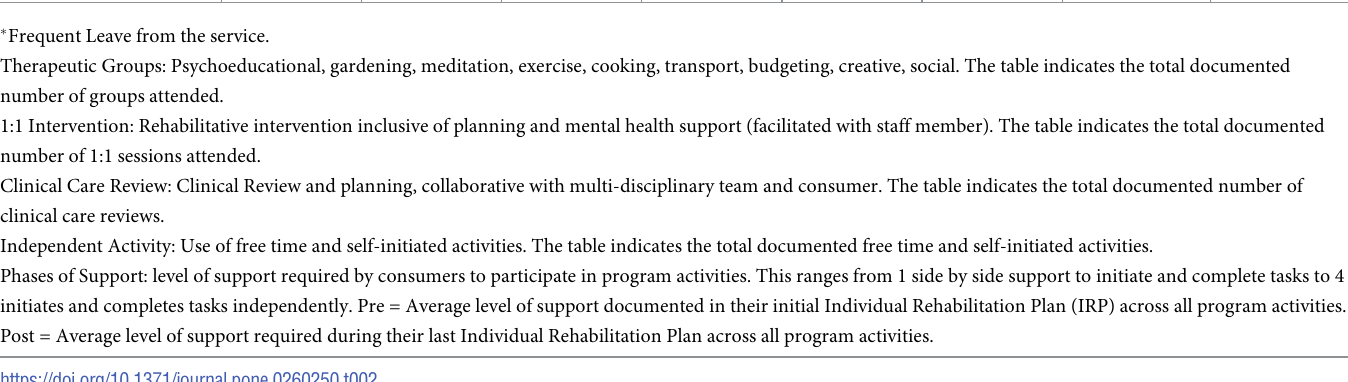
Therapeutic Groups: Psychoeducational, gardening, meditation, exercise, cooking, transport, budgeting, creative, social. The table indicates the total documented number of groups attended. 1:1 Intervention: Rehabilitative intervention inclusive of planning and mental health support (facilitated with staff member). The table indicates the total documented number of 1:1 sessions attended. Clinical Care Review: Clinical Review and planning, collaborative with multi-disciplinary team and consumer. The table indicates the total documented number of clinical care